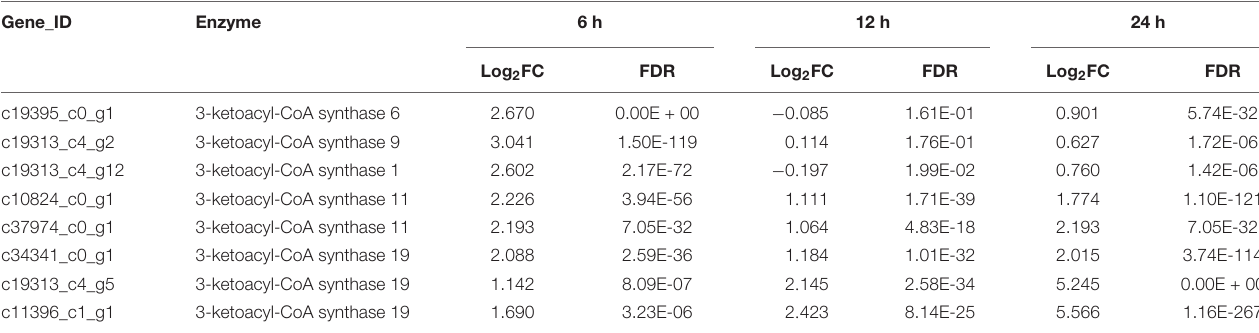
FIGURE 7 | Changes in transcript abundance of genes involved in fatty acids biosynthesis of heterotrophically grown S. acuminatus cells subjected to the high-light and N-limited conditions. Genes upregulated were indicated in red. Genes downregulated were indicated in blue. Genes upregulated and downregulated at different time points were indicated in green. No significant changes were indicated in black. The full names of the corresponding genes are given in Supplementary Table 9 . TABLE 3 | Changes in transcript expression of several genes related to very-long-chain fatty acids synthesis for the heterotrophically grown S. acuminatus cells subjected to the high-light and N-limited